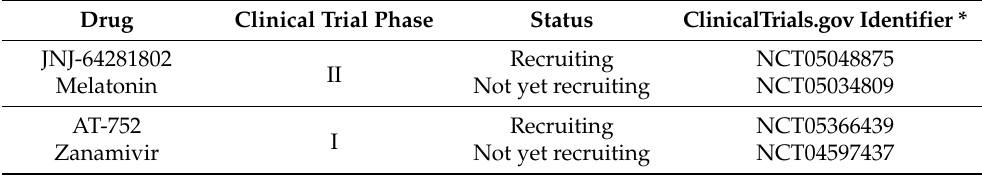
Table 1. DENV antivirals that are currently undergoing clinical